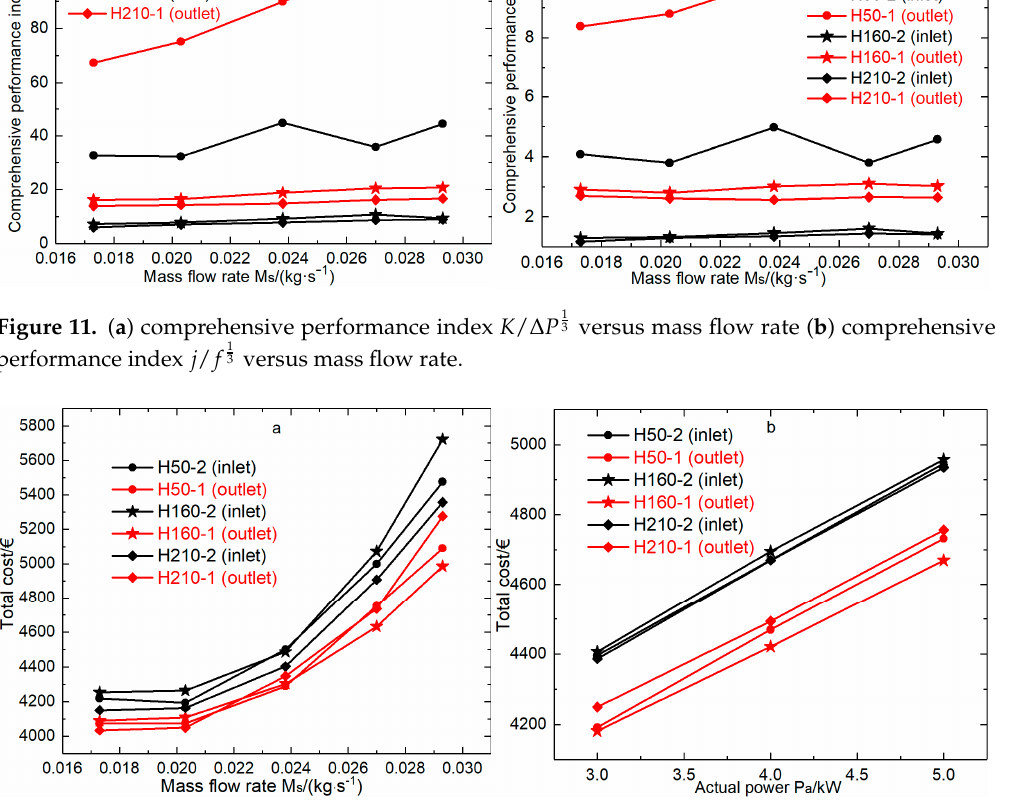
Figure 12. The total cost versus ( a ) mass flow rate and ( b ) actual power.